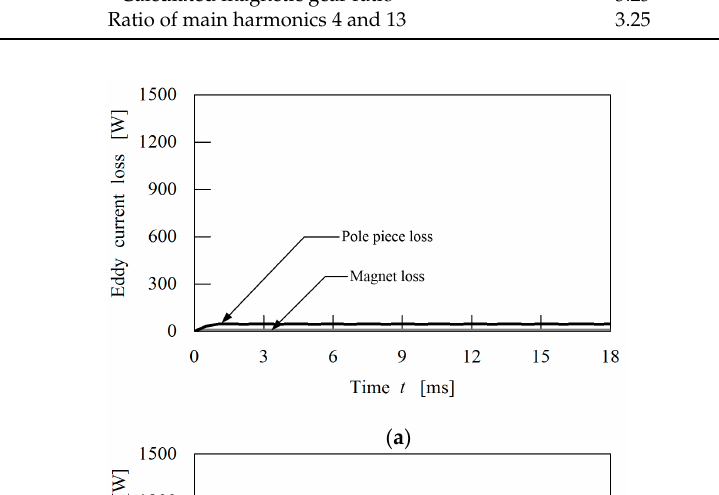
Table 5. Inner air-gap flux density performance of the magnetic gear.